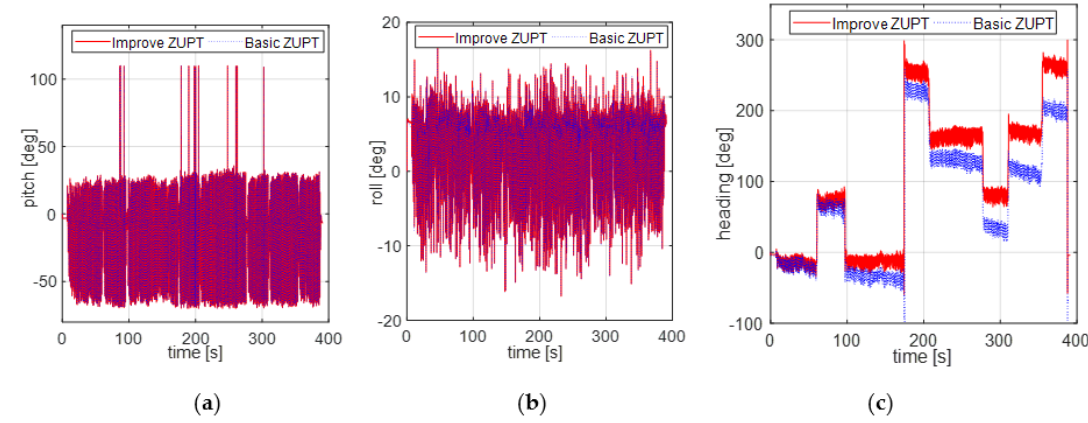
Figure 8. Pedestrian heading estimation result. ( a ) Pitch; ( b ) Roll; ( c )